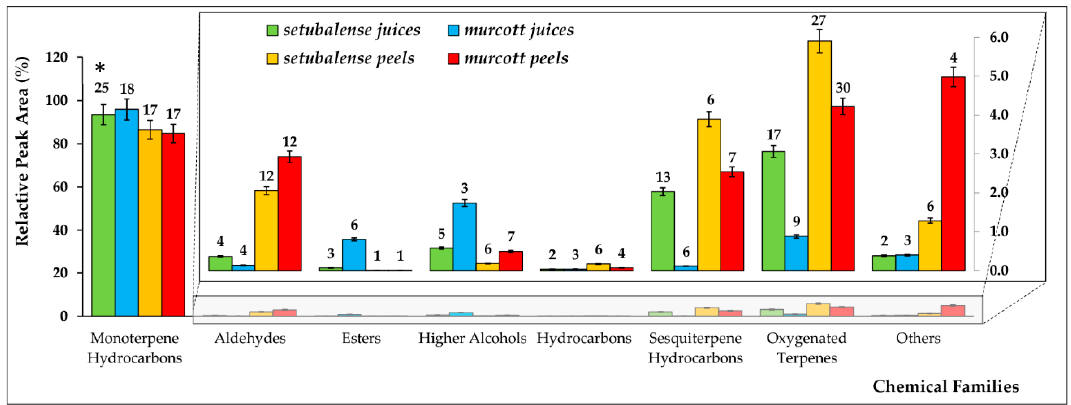
Figure 2. VOMs identified in juices and peels of setubalense and murcott tangerines, by chemical family. The numbers close the bars (*) indicates the number of identified VOMs in each chemical family.